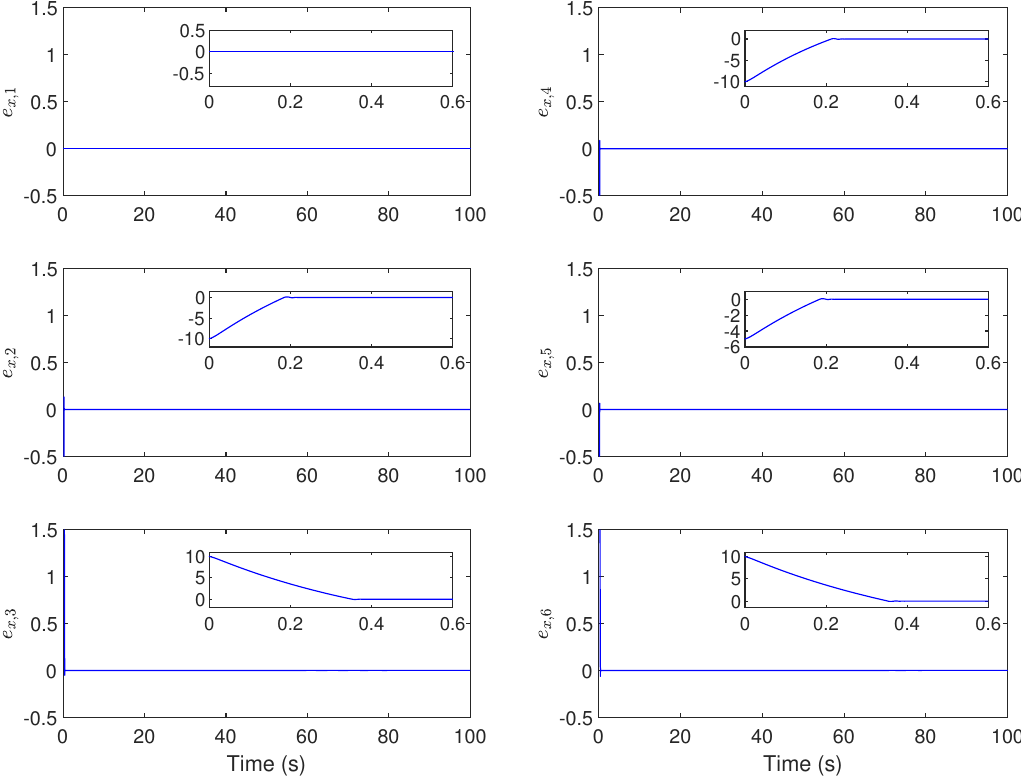
Figure 10. State estimation errors for the distributed SMOs when u d , i = 0 for i =